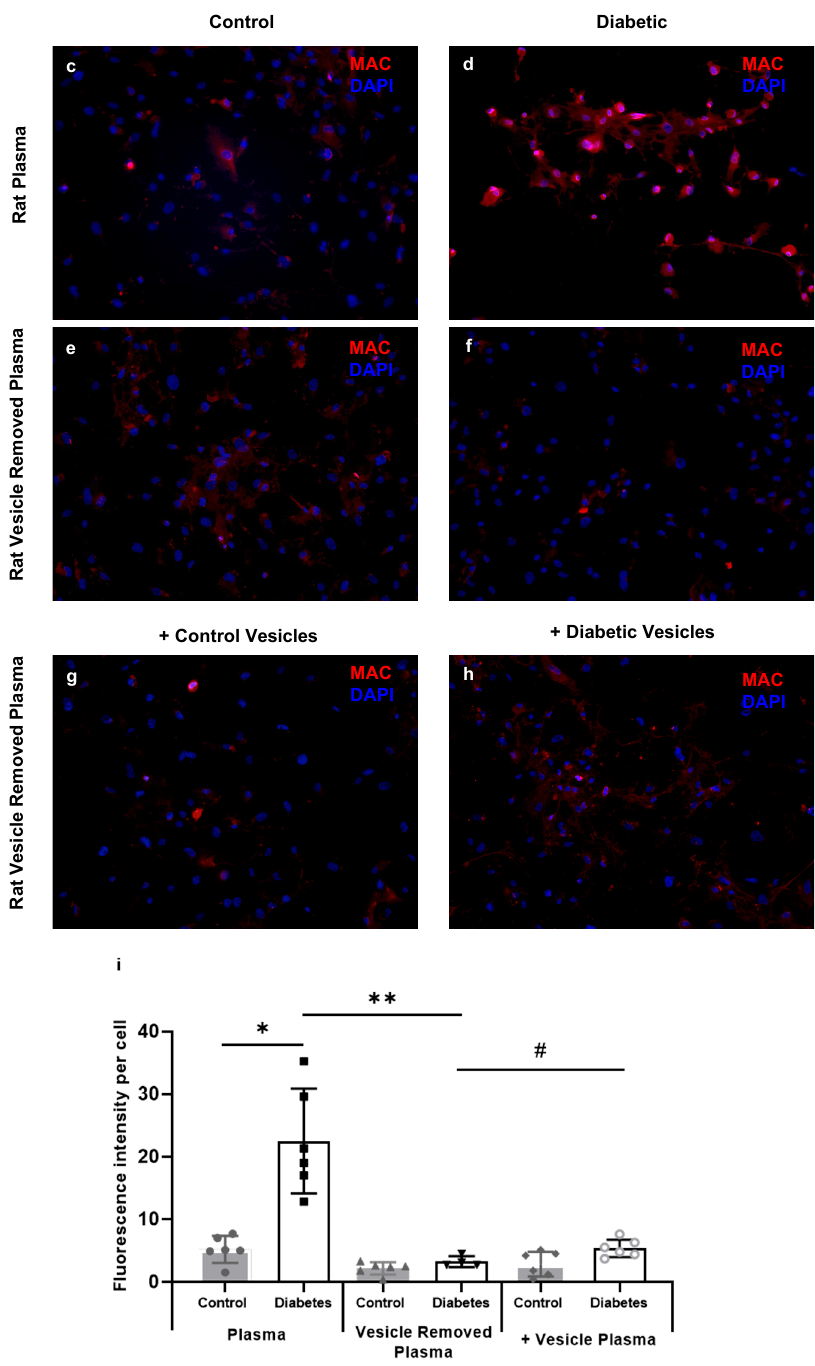
Figure 4. Diabetic rat plasma induced cytotoxicity and cell death in human retinal endothelial cells (HRECs). STZ-induced diabetic (seven weeks) rat plasma was collected from tail artery and extracellular were removed via ExoQuick combined with ultracentrifugation method. ( a ) With LDH Assay; after 6 h, (*) diabetic rat plasma (white bar) treated human retinal endothelial cells (HRECs) showed a significant increase of cytotoxicity compared to control plasma treated HRECs (grey bar). (**) When extracellular vesicles were removed from diabetic plasma (white bar), cytotoxicity was reduced compared with diabetic plasma treated HRECs (white bar). (#) After adding diabetic extracellular vesicles back into the vesicle-removed plasma condition, cytotoxicity showed a significant increase when compared with the diabetic vesicle-removed condition (white bars). LDH concentration from no cell conditions were subtracted from each condition before calculation of cytotoxicity. ( b ) Trypan Blue staining of detached HRECs showed similar results as LDH